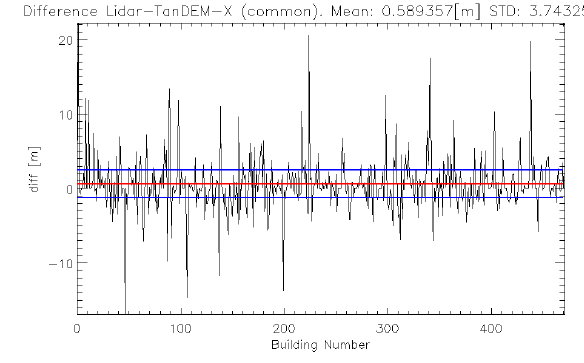
Figure 4: Buildings mean height difference between LiDAR and TanDEM-X using for LiDAR segmentation. The red and blue lines represent respectively the measured mean and the standard